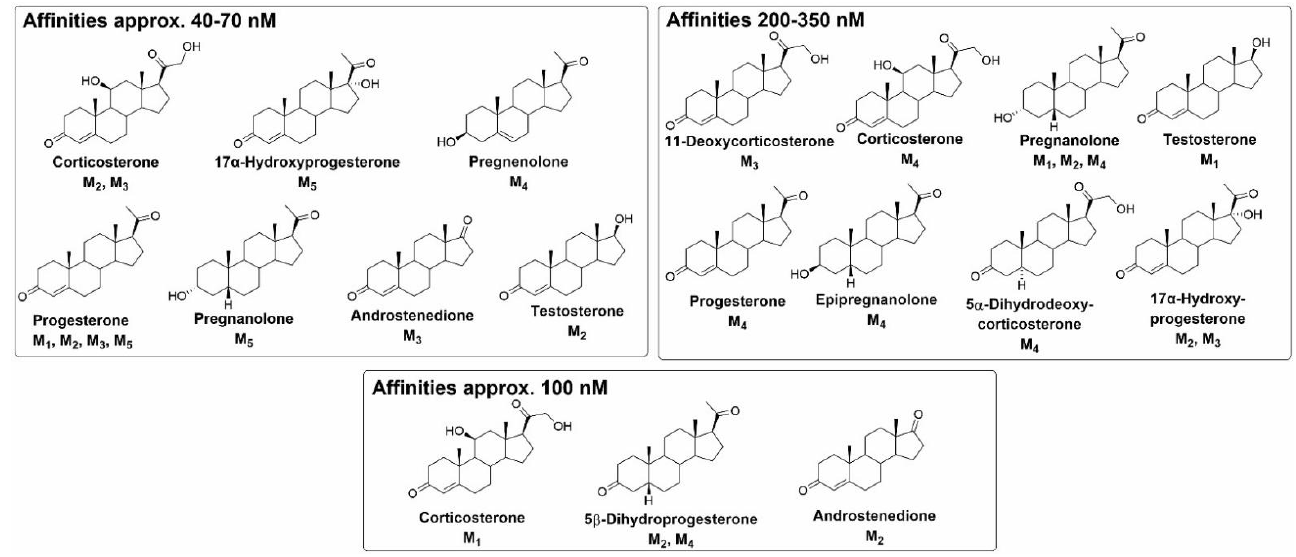
Figure 8. Overview of binding affinities to individual muscarinic receptor subtypes from [46]. Four compounds, in particular corticosterone, progesterone, estradiol and testosterone, affected the functional response of mAChRs at physiologically relevant concentrations. The influence of steroids on mAChRs functional response to ACh was quantified by changes in specific [ 35 S] GTPγS binding to membranes expressing M 2 or M 4 , or inositol phosphates accumulation in CHO cells expressing M 1 , M 3 or M 5 receptors. Corticosterone induced a 3-fold increase in ACh potency at M 2 , but decreased it 3-fold at the M 4 receptor. Proges- terone increased the efficacy of ACh receptors by 30% at M 1 and by 20% at M 3